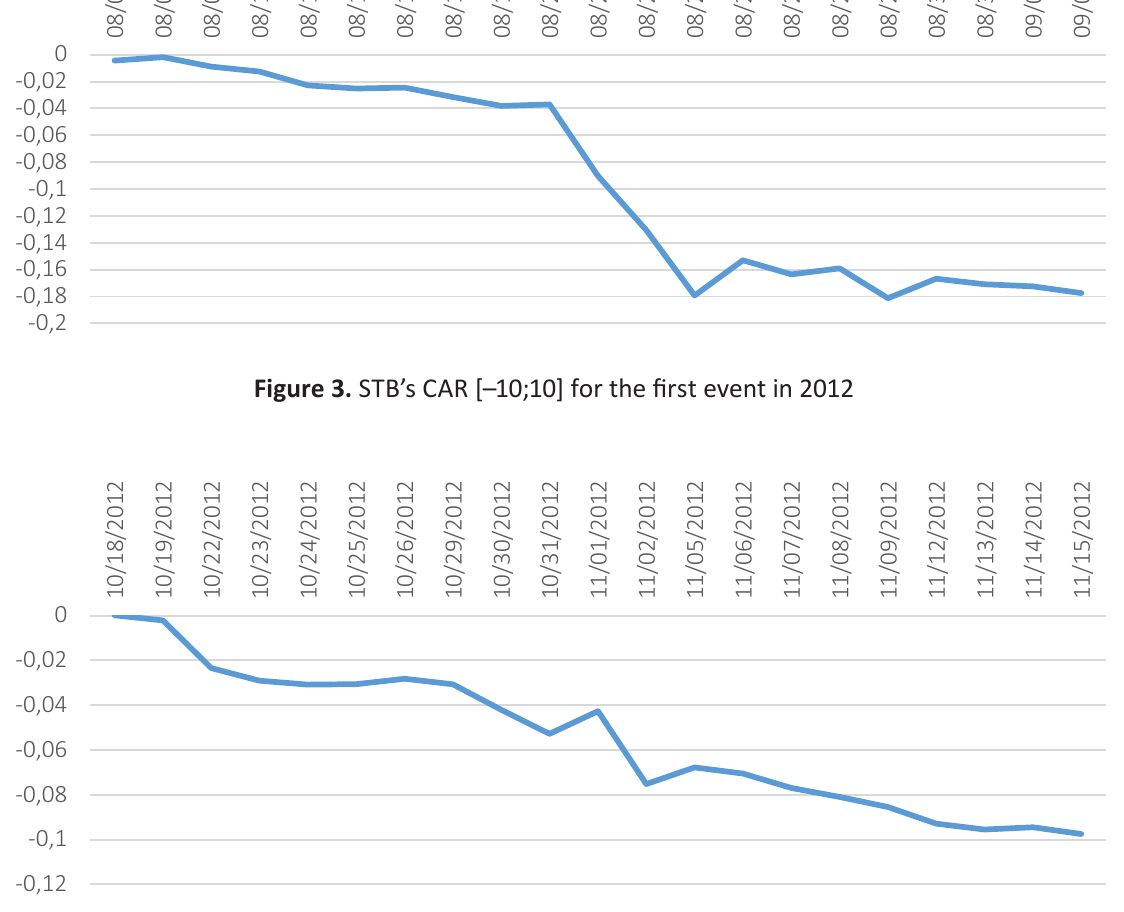
Figure 4. STB’s CAR [–10;10] for the second event in